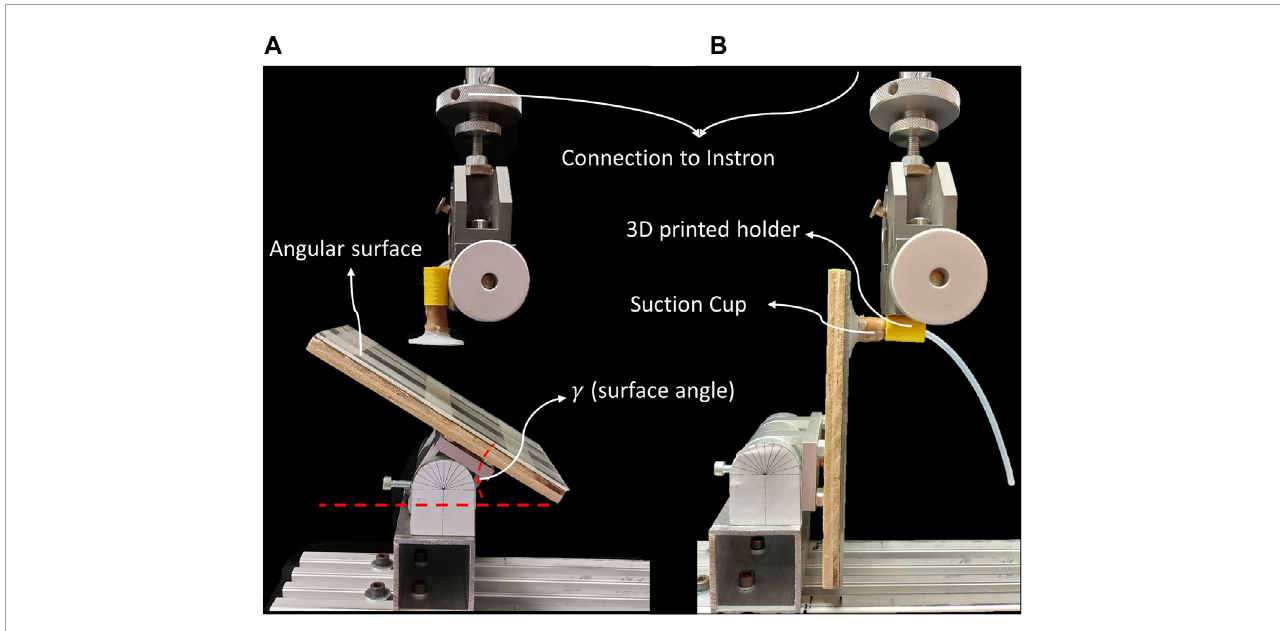
FIGURE 4 The setup used for adaptation and bending stiffness test. (A) the adaptation test setup: (B) The bending stiffness test setup.